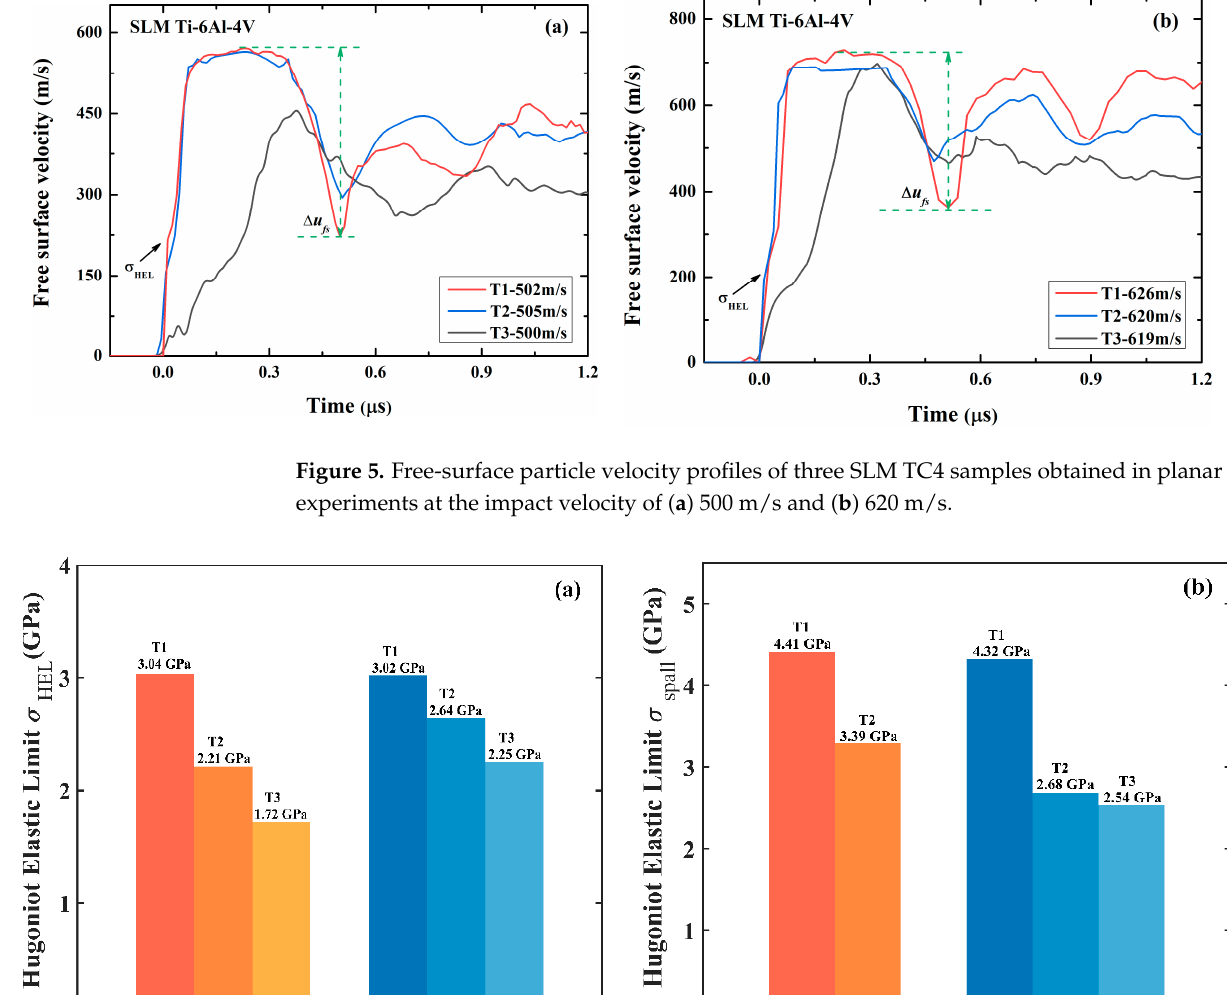
Figure 7. Optical metallography of three SLM TC4 samples shock ‐ recovered at the impact velocity of (a)(b)(c) 500 m/s and (d)(e)(f) 620 m/s.